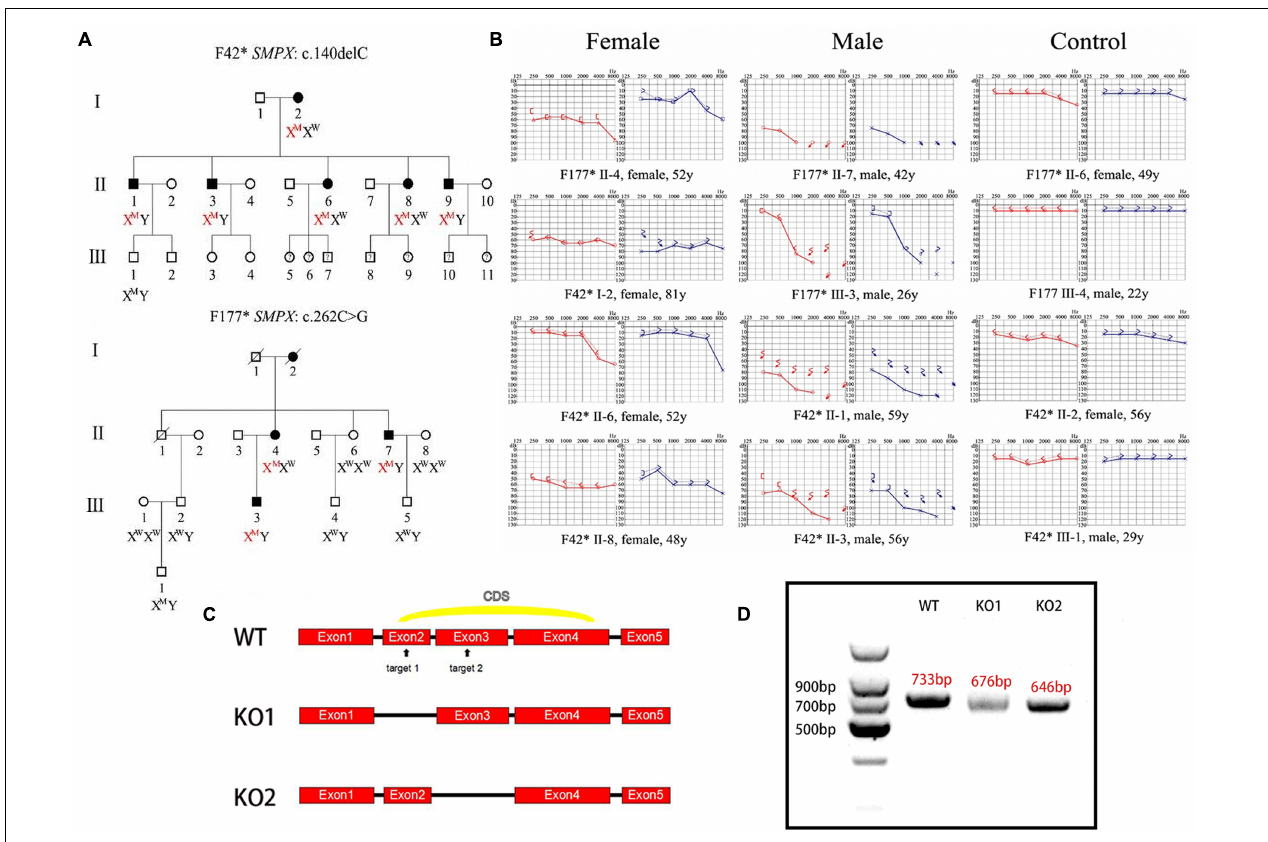
FIGURE 1 | Clinical phenotype and mouse model construction. (A) Pedigree of two Chinese families affected by DFNX4. Solid objects mean gene defect; hollow objects mean unaffected members; squares represent males; circles represent females. This pedigree indicated an X-linked dominant inheritance. (B) Audiograms of affected family members. Red indicates right ear and blue indicates left ear. We discovered that the hearing threshold of two ears was almost the same except F177 ∗ II-4’s; hearing loss was more serious in male than female mice; Hearing loss was significantly worse in high frequency than that in low and medium frequencies and varied among individuals. (C) Schematic diagram of Smpx KO mouse construction. Two target sites were chosen in exon 2 and 3 (arrowed); two KO models were obtained. (D) Agarose gel electrophoresis of cDNAs acquired from knock-out mice. We cloned the whole Smpx CDS of these two knock-out pattern and discovered 57 and 87 bps deletions, which were exactly the whole length of exons 2 and